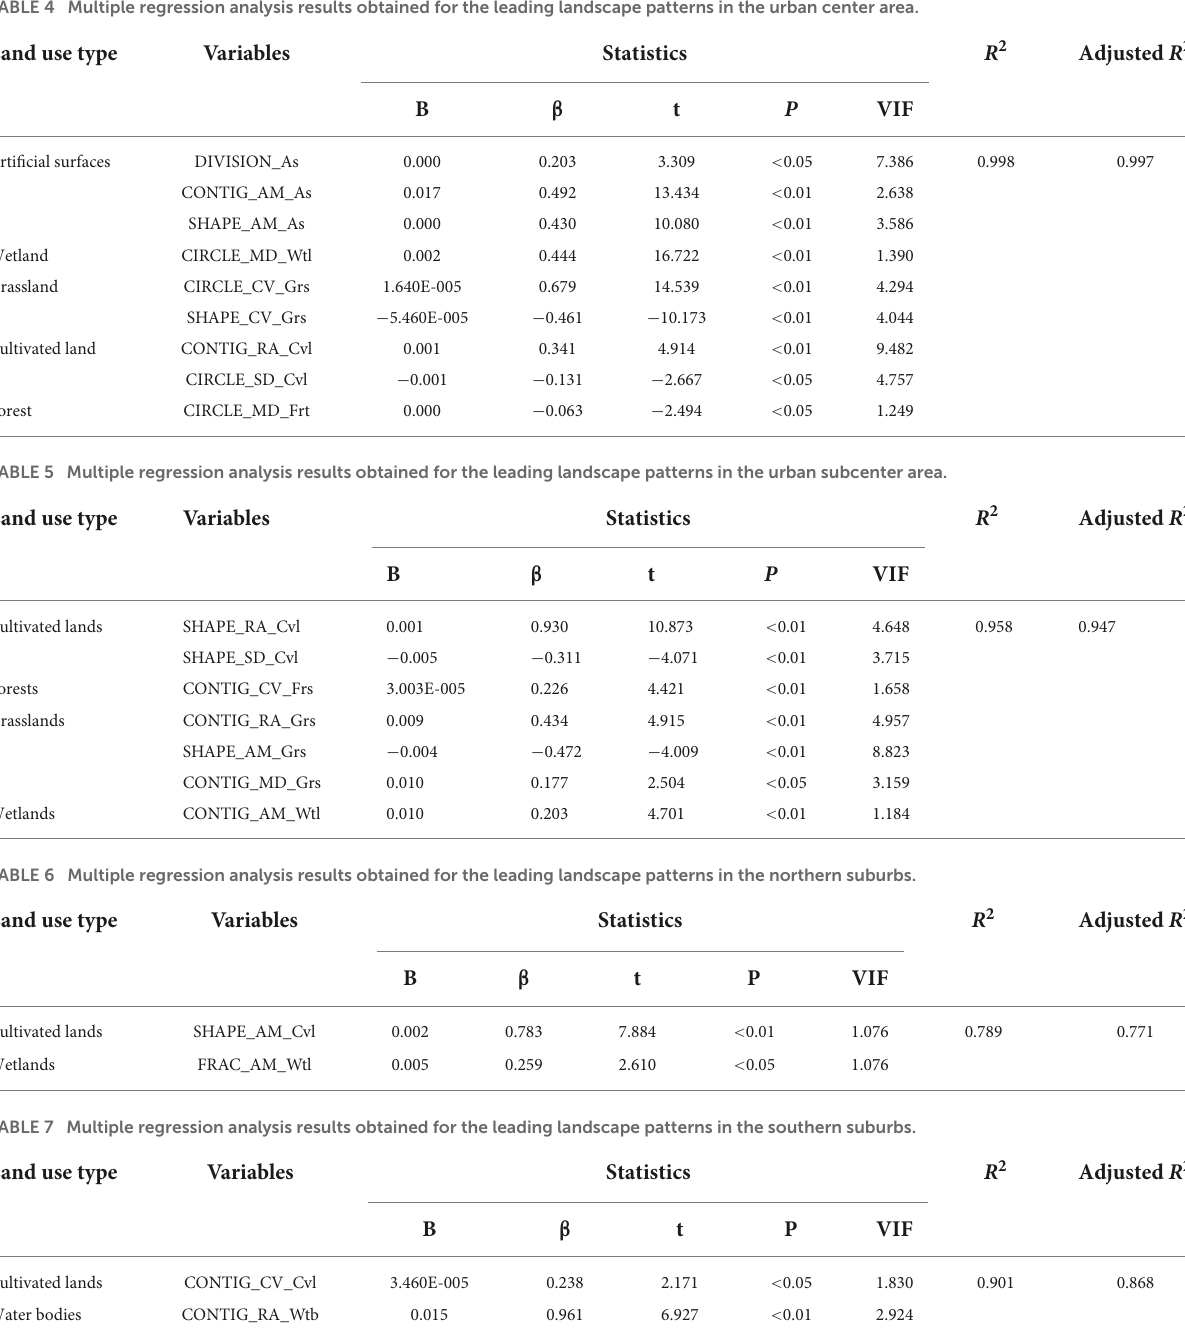
TABLE 4 Multiple regression analysis results obtained for the leading landscape patterns in the urban center area.